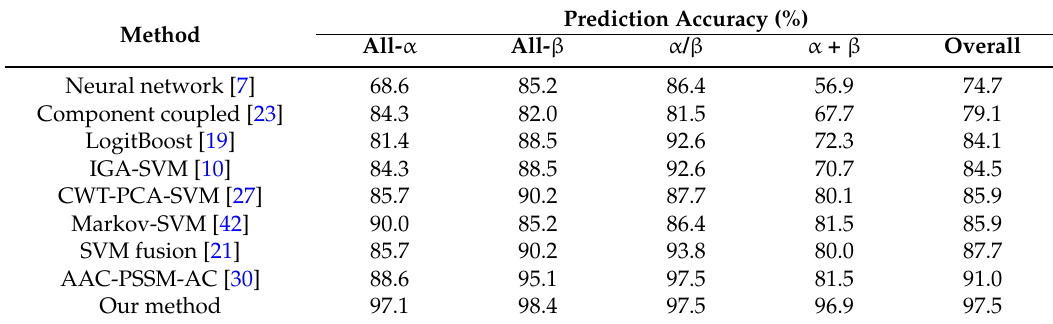
Table 2. Comparison of different methods by the jackknife test for the Z277 dataset.